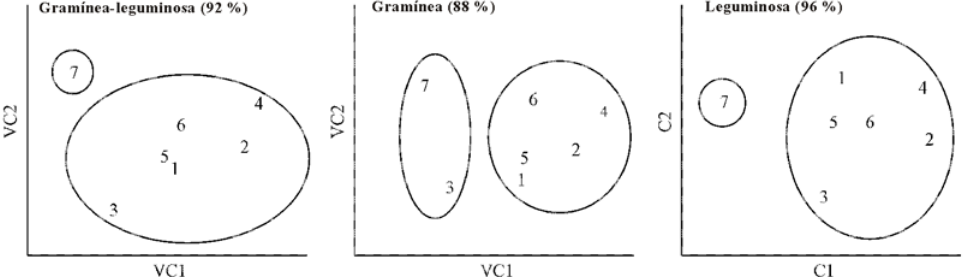
Figura 1. Dispersão dos sete porta-enxertos em relação às duas variáveis canônicas (VC1 e VC2) e aos dois primeiros componentes principais (C1 e C2), agrupados pelo método de Tocher (círculos e elipses), para produção, número de frutos e desenvolvimento vegetativo das plantas da laranjeira ‘Folha Murcha’, em sistemas de manejo da cobertura do solo com gramínea-leguminosa, gramínea e leguminosa. Porta- enxertos: 1 - (limoeiro ‘Cravo’), 2 - (limoeiro ‘Rugoso da África’), 3 - (limoeiro ‘Volcameriano’), 4 - (tangerineira ‘Cleópatra’), 5 - (tangerineira ‘Sunki’), 6 - (citrangeiro ‘C-13’) e 7 - (trifoliata). Os percentuais dentro dos parênteses correspondem aos valores dos dois primeiros autovalores.